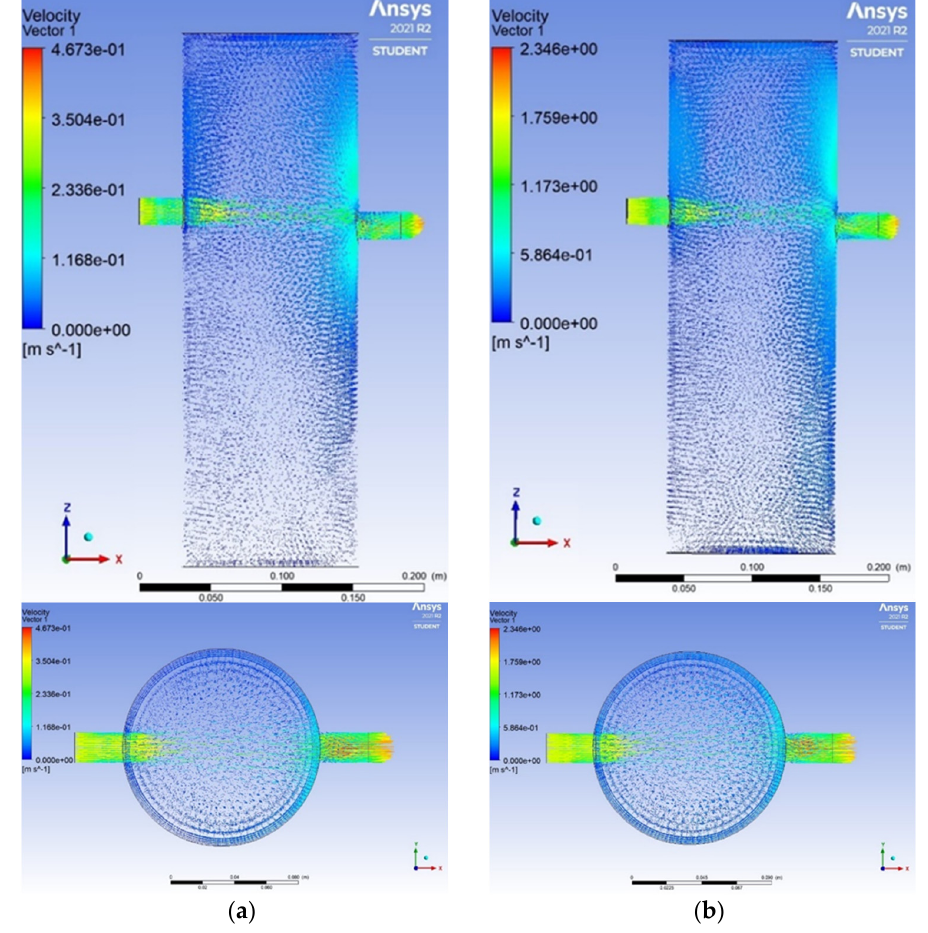
Figure 5. Velocity vector fields for the OS model in the case of velocity. ( a ) v 1 ; ( b ) v 5 .